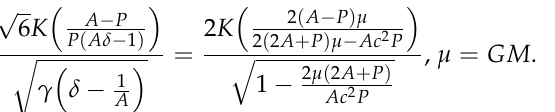
Figure 5. The curve (94)